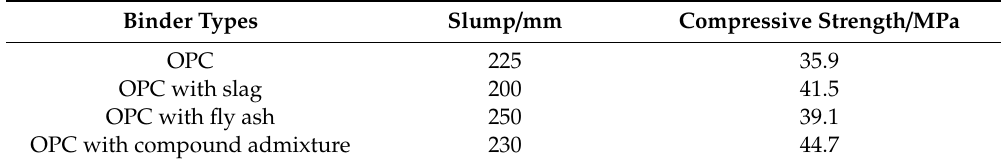
Table 4. Workability and compressive strength of concrete.